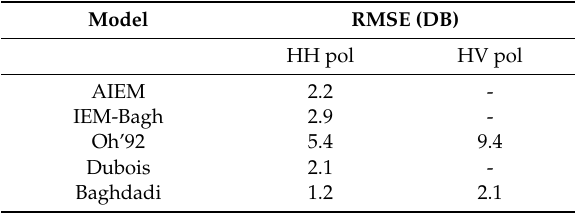
Figure 9. Comparison between real radar data and simulations using different physical or semi-empirical models: ( a ) HH polarization; ( b ) HV polarization. Table 1. Root mean square (RMS) errors between simulated and real radar data, using five different physical or semi-empirical models.